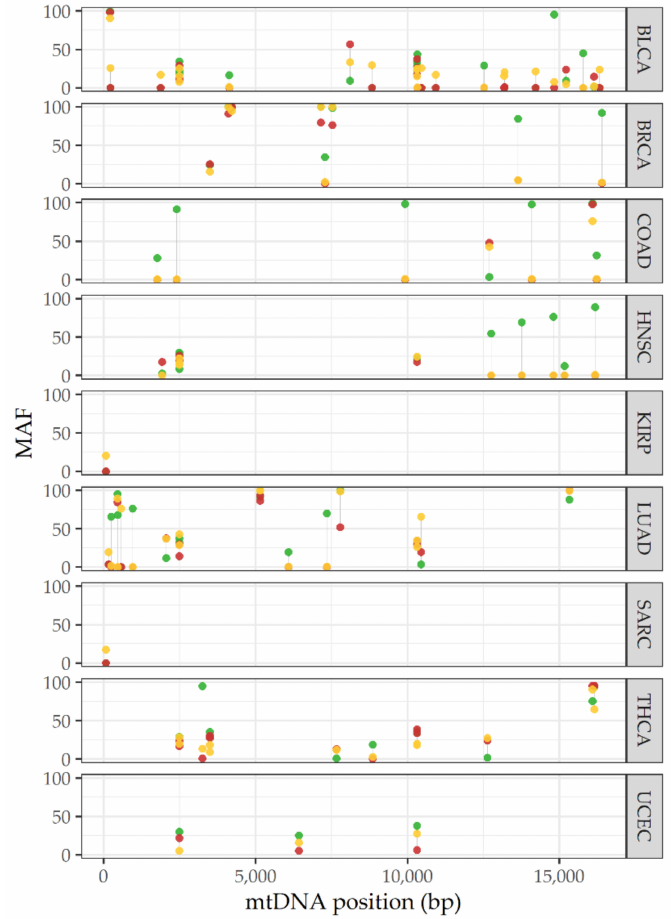
Figure 3. Landscape of heteroplasmy shifting in cancer. Mutant allele frequency (MAF) in peripheral blood (red points), adjacent tissue (yellow points) and tumor (green points) for each mitochondrial heteroplasmic site in several types of cancer. The graph is derived from 86 selected heteroplasmic sites reported by Grandhi et al. (public data) [17]. BLCA: bladder urothelial carcinoma; BRCA: breast invasive carcinoma; COAD: colon adenocarcinoma; HNSC: head and neck squamous cell carcinoma; KIRP: kidney renal papillary cell carcinoma; LUAD: lung adenocarcinoma; SARC: sarcoma; THCA: thyroid carcinoma; UCEC: uterine corpus endometrial carcinoma; bp: base